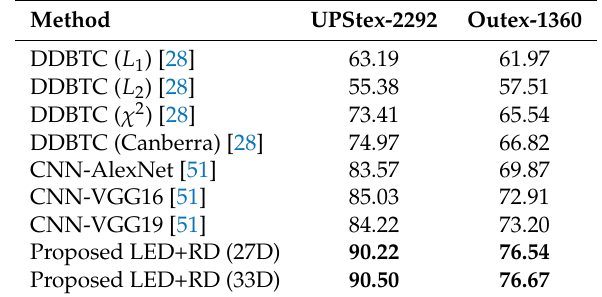
Table 6. Average retrieval rate (%) on USPtex-2292 and Outex-1360 databases by the proposed method compared to some reference methods.